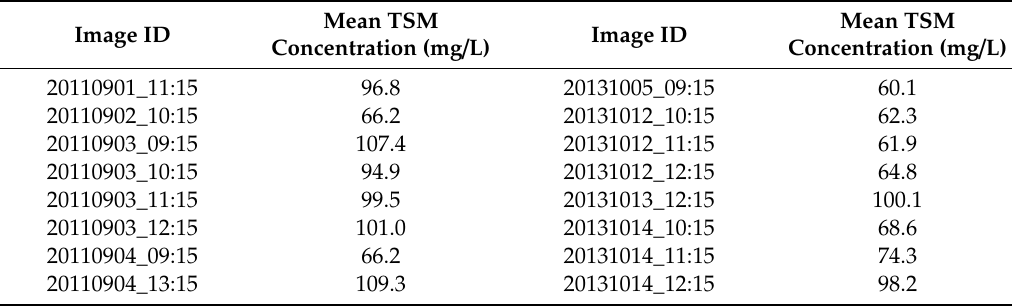
Figure 7. Percentage of total lake area accounted for by different TSM concentrations (percent) in Lake Taihu in mid-October 2013. Table 4. The mean TSM concentrations in Lake